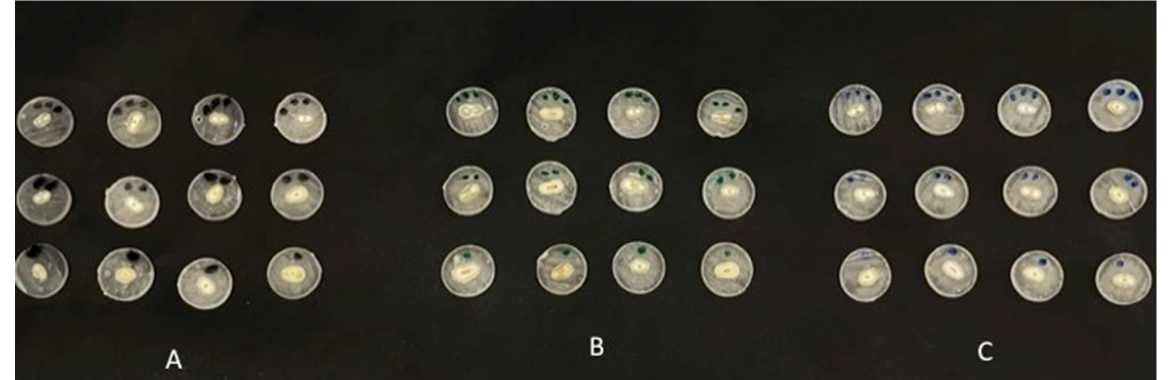
Figure 2. Specimen sections in the study groups. ( A ) EA (control). ( B ) 5% TiO 2 . ( C ) 5% ZrO 2 .